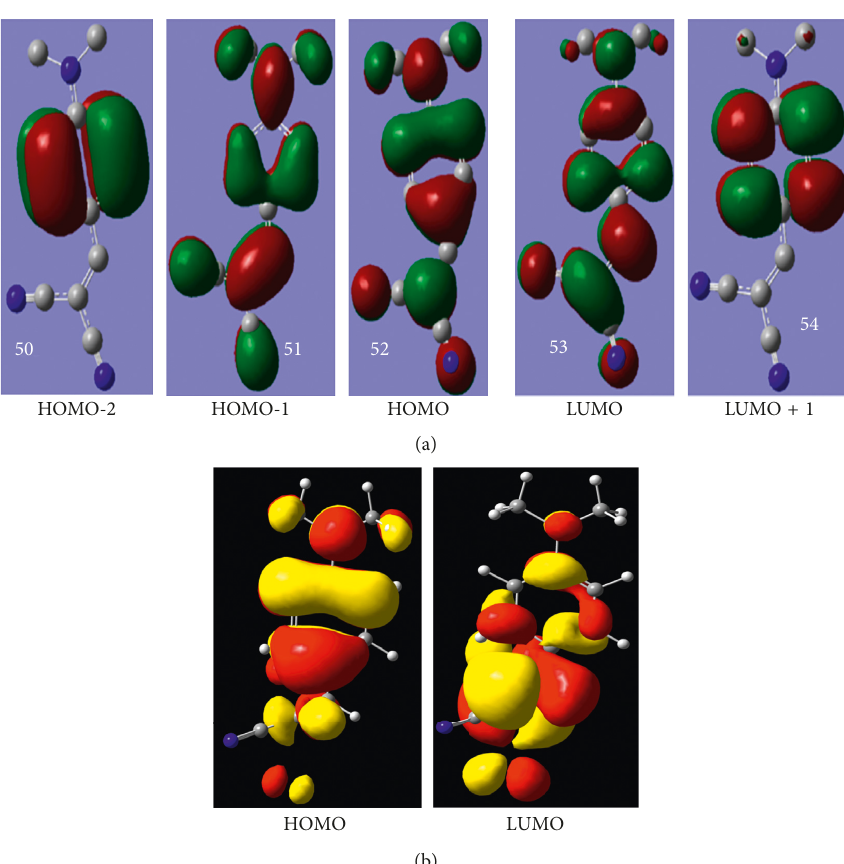
F IGURE 10: Gaussian’16 results depicts (a) the MO surfaces involved in the electronic transitions from the 1 st and 2 nd singlet excited states to the ground state and shows clearly (b) the CT nature reflected in HOMO-LUMO involved in electronic transition in a twisted state. Both MO’s shown in (a) and (b) are obtained by Gaussian’16 package. We used different color codes to illustrate the difference between planar and twisted structures. The isovalue for all surfaces is 0.02. All surfaces are plotted by GaussView 6. (a) Planar configuration. (b) Twisted configuration: scan step 18 shown in the inset Figure 9(b).